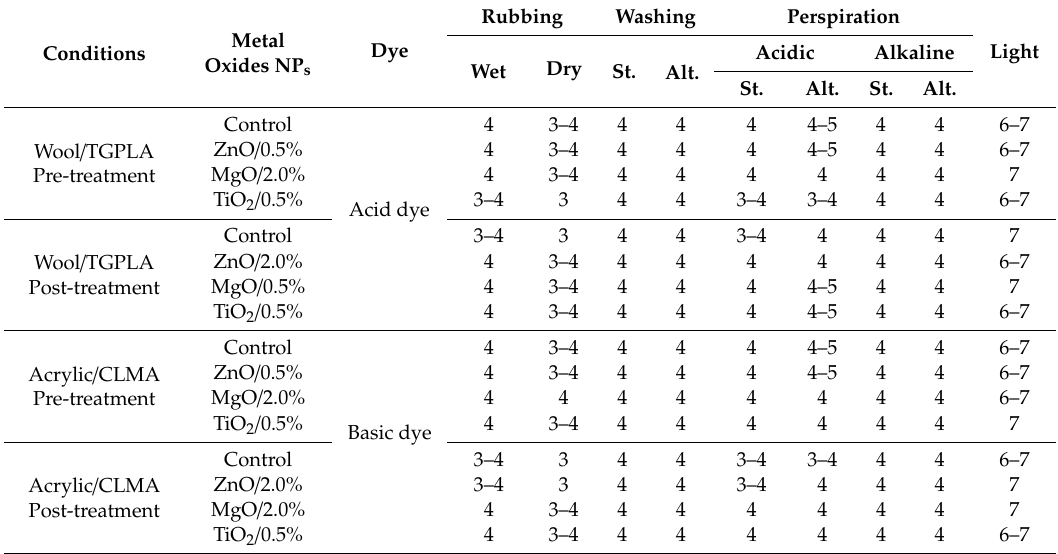
Table 5. Colorfastness properties of wool and acrylic fibers pre- and post-treated with nanoparticles and printed with acid or basic dyestu ff s employing TGPLA or CLMA thickeners, respectively.